Question: Condense the content of this figure into a single sentence.
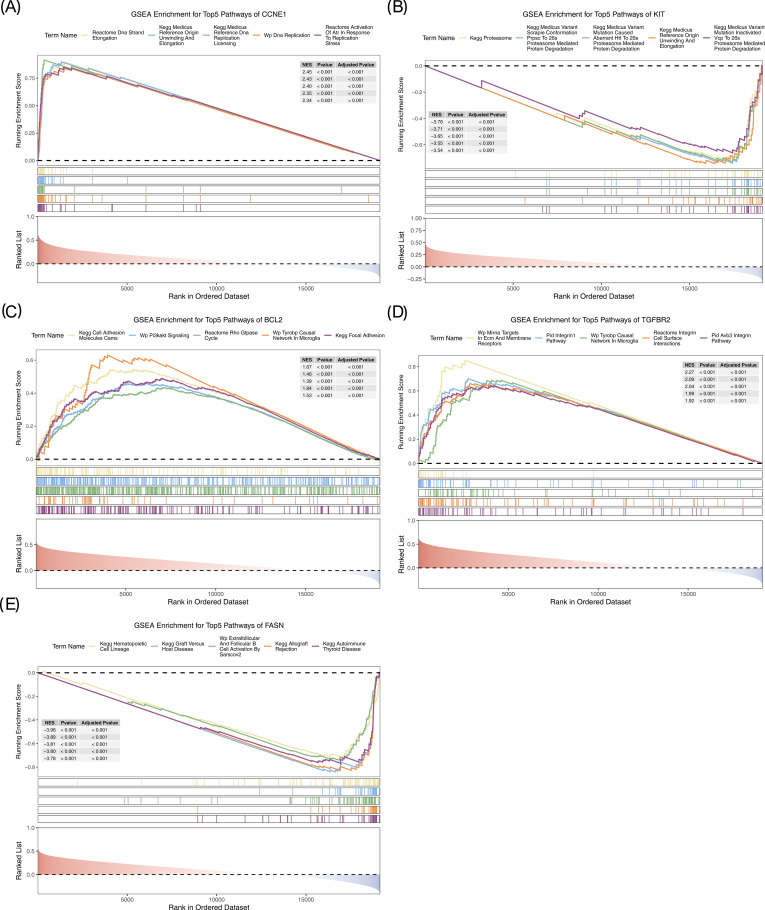
Answer: GSEA plots of top 5 enriched pathways for indicated genes. (A) Top five positively enriched pathways in CCNE1-high signature. (B) Top five negatively enriched pathways in KIT-high signature. (C) Top five positively enriched pathways enriched in BCL2-high signature. (D) Top five positively enriched pathways enriched in TGFBR2-high signature. (E) Top five negatively enriched pathways depleted in FASN-high signature. Each panel displays running enrichment score curves, ranked gene lists and corresponding normalized enrichment score (NES), P-value and adjusted P-value for each pathway.